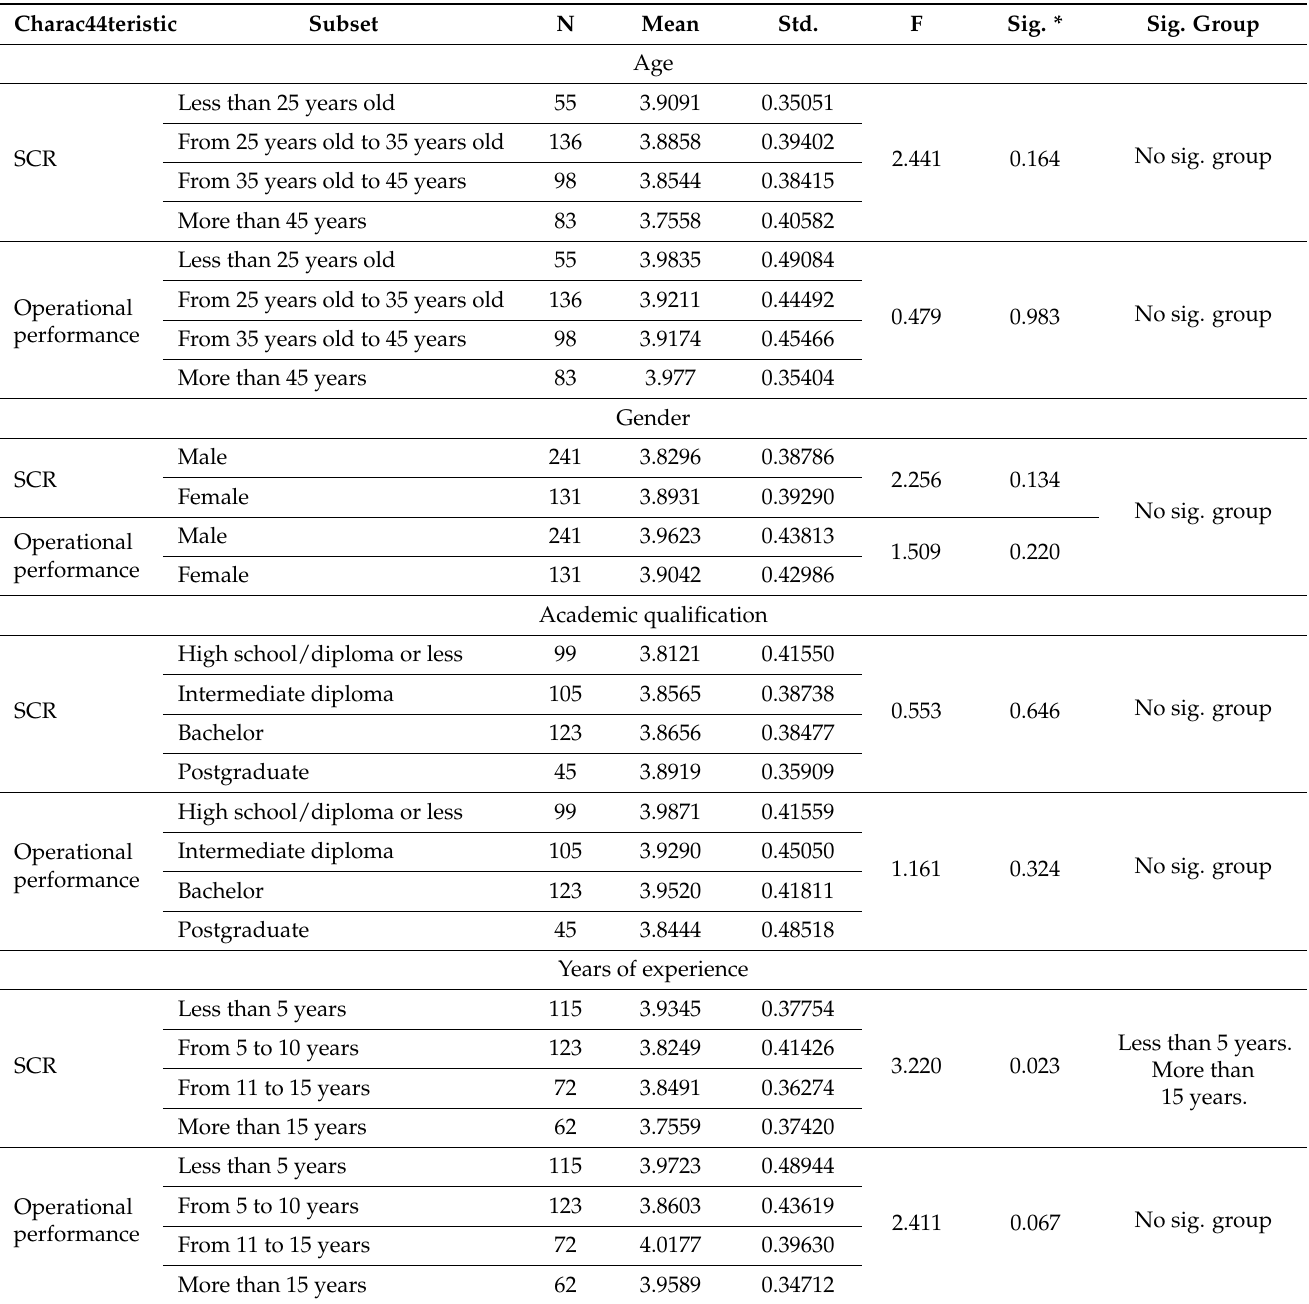
Table 12. ANOVA test outcomes—Demographics (N =